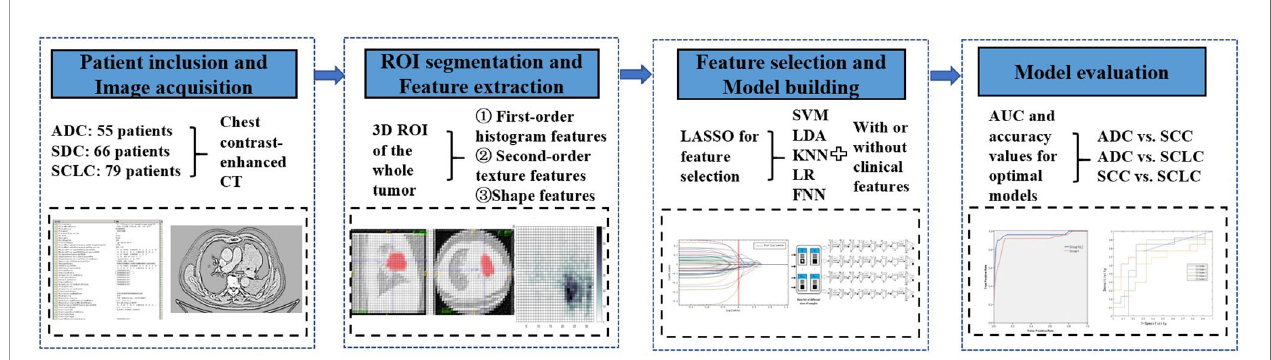
FIGURE 1 | Work fl ow of classi fi